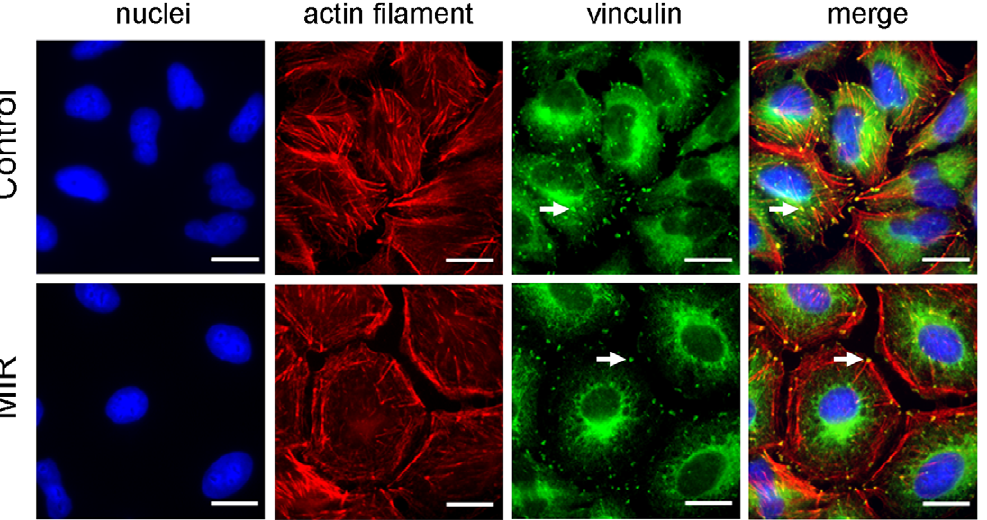
Figure 3. Effect of MIR exposure on the actin filaments and focal adhesions of A549 cells. Cells were seeded onto glass coverslips in 12- well plates, exposed to MIR for 48 hours, fixed for staining and visualized by fluorescence microscopy. Actin filaments were tagged with rhodamine- labeled phalloidin (red), vinculin was labeled with mouse anti-vinculin antibody and the corresponding FITC– conjugated secondary anti-mouse IgG antibody (green), and nuclei were stained with DAPI (blue). Scale bar represents 10 m m. Arrows indicate the position of